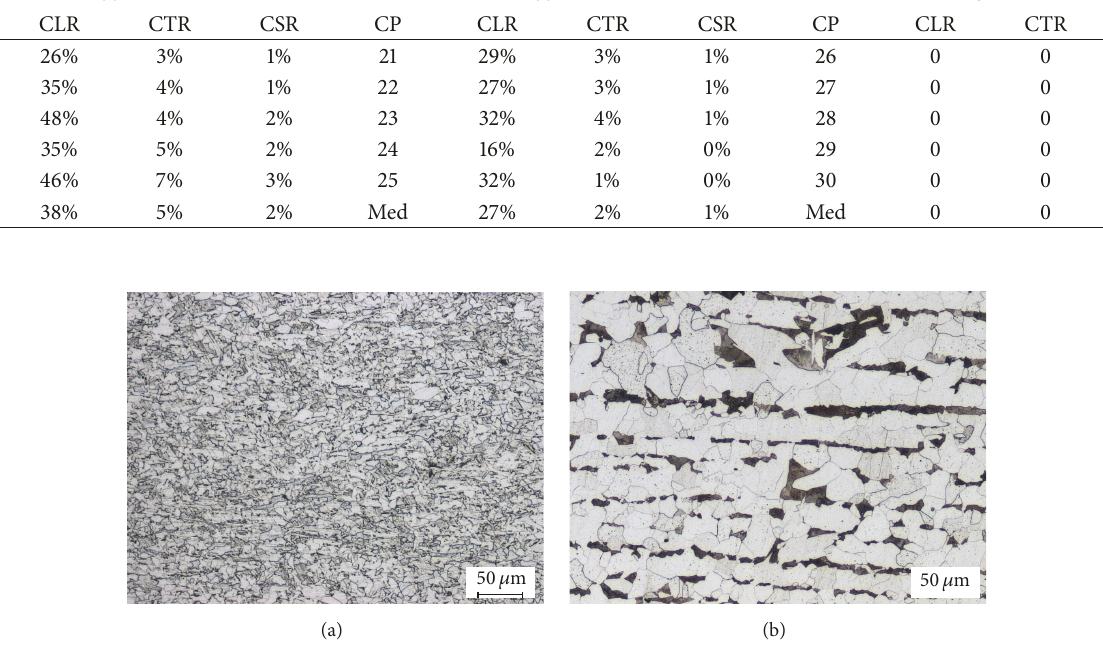
Figure 2: Microstructure of the central region of the API 5L steel plates: (a) X52MS and (b) B (metallographic etchant: 3.0% nital solution).